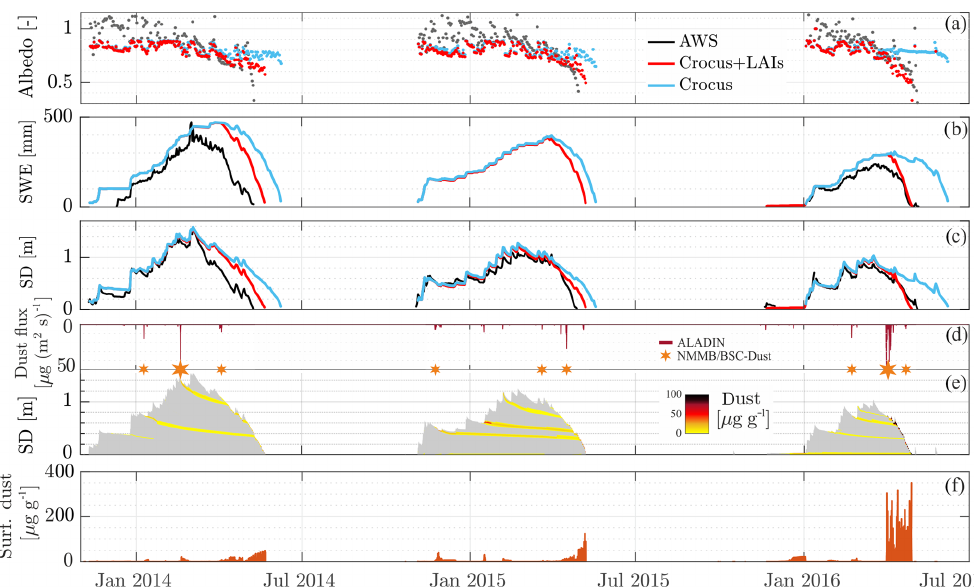
Figure 3. (a, b, c) Time series of albedo, snow water equivalent (SWE), and snow depth (SD) measured with the AWS and simulated with Crocus model including and excluding the impact of LAPs. SWE data are missing in December 2013 because of problems with the power supply. (d) Dust fluxes simulated with ALADIN (maroon bars, note that the scale is inverted), and strong (large stars) and weak (small stars) dust events simulated with NMMB/BSC-Dust. (e) Dust concentration (µgg − 1 ) in the snowpack (yellow to black palette) simulated with Crocus and superimposed on the snow depth profile (grey shaded area). (f) Surface concentration (averaged over the first 10cm) of dust simulated with Crocus.